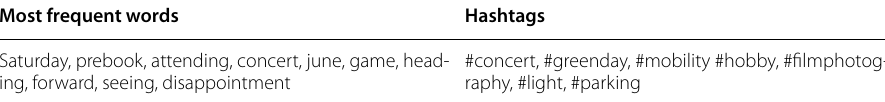
Table 9 Hashtags, and most frequent words within the event community Most frequent